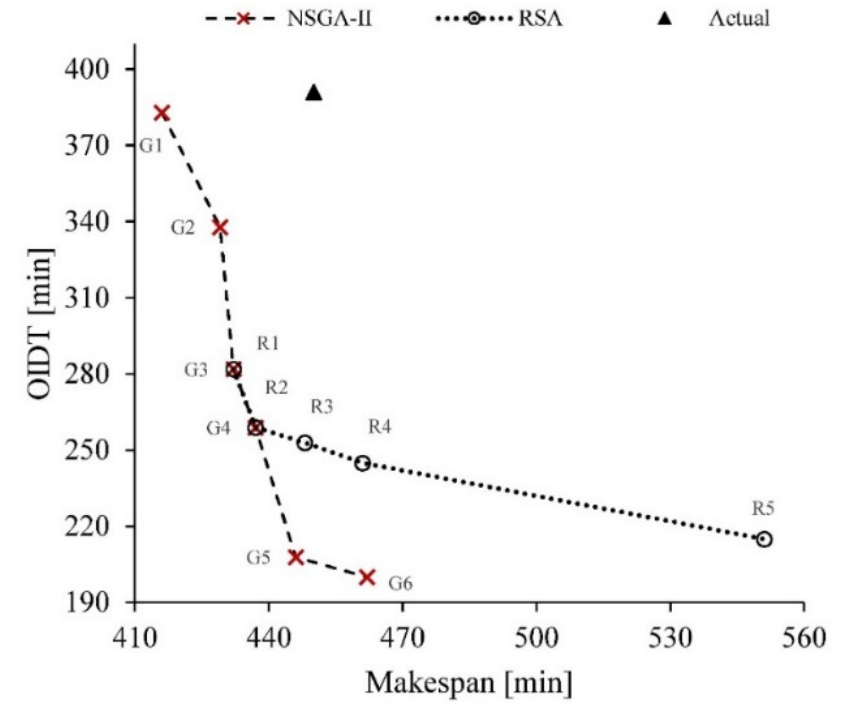
Figure 16. The solutions offered by NSGA-II and RSA for BMP-V.